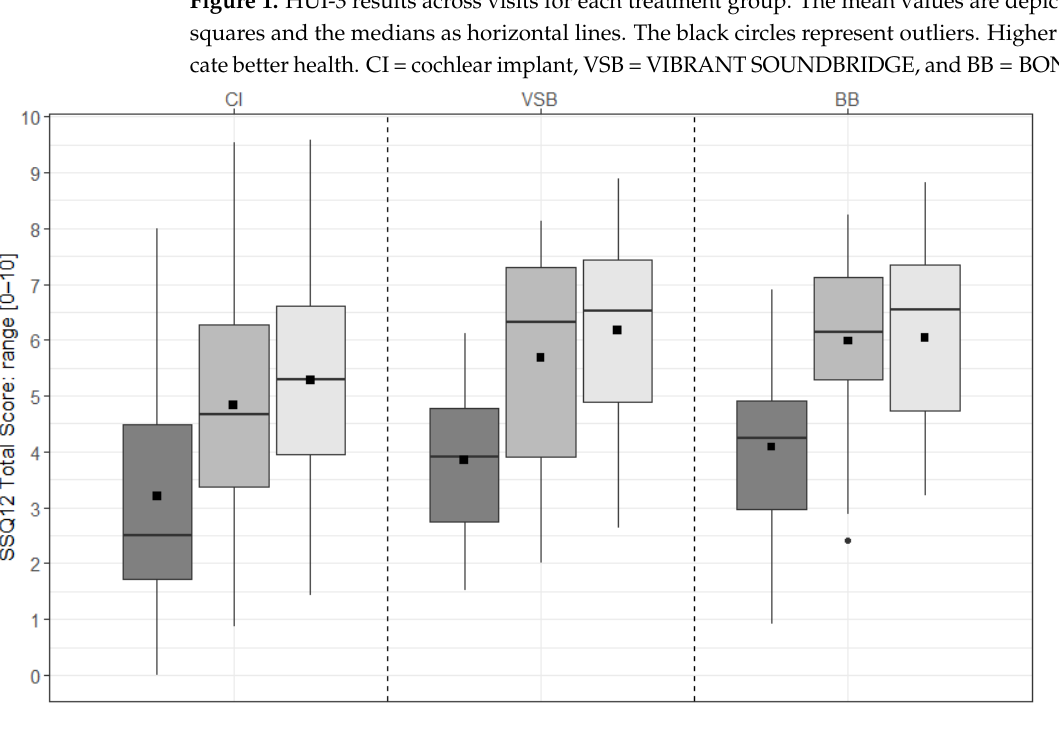
Figure 2. SSQ 12 total scores across visits for each treatment group. The mean values are depicted as black squares and the medians as horizontal lines. The black circle represents an outlier. Higher scores indicate better hearing ability. CI = cochlear implant, VSB = VIBRANT SOUNDBRIDGE, and BB = BONEBRIDGE.